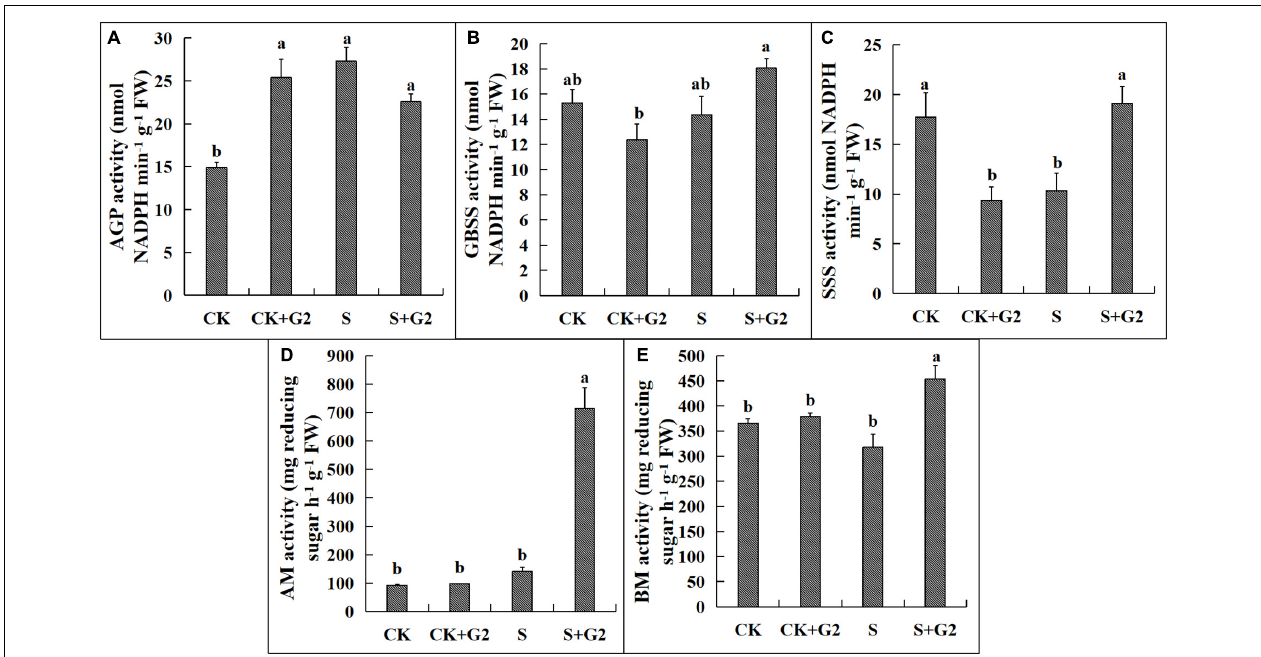
FIGURE 5 | Effects of B. cereus G2 on enzymes related to starch synthesis and decomposition in G. uralensis seedlings under control and salt stress conditions. CK, control group; S, salt stress group; CK + G2, control combined with the G2 group; S + G2, salt stress combined with the G2 group. The different letters within the different treatments in the same parameter indicate the significant difference at the 0.05 level. Values are means ± SE ( n = 3). (A) AGP: ADP-glucose pyrophosphorylase. (B) GBSS: granule-bound starch synthase. (C) SSS: soluble starch synthase. (D) AM: α -amylase; (E) BM: β